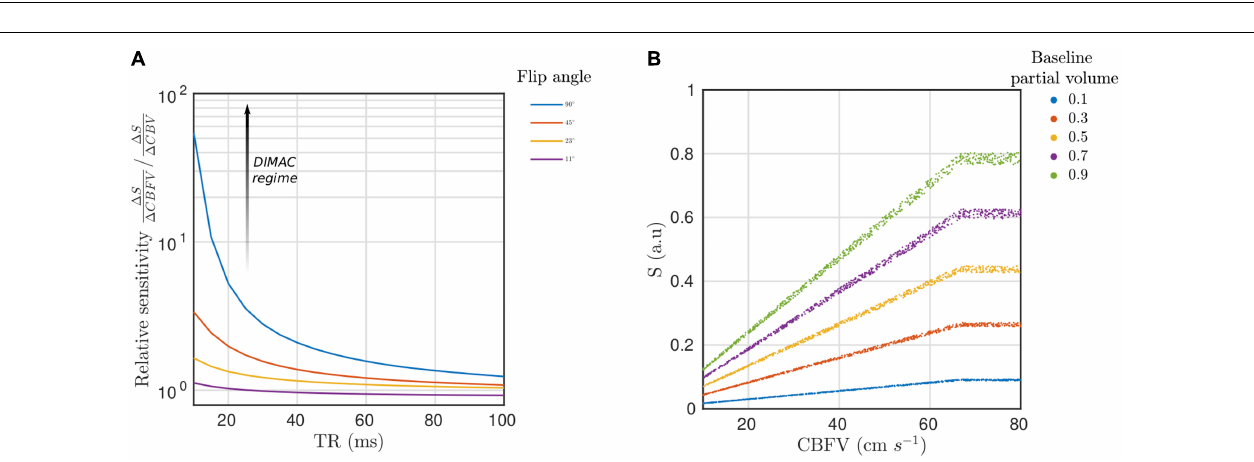
FIGURE 2 | (A) The average amount of variance explained in the beat-to-beat fit as a function of the number of Fourier terms used. (B) An example showing detected diastolic troughs and the beat-to-beat pulsatile fits taken from a representative subject.